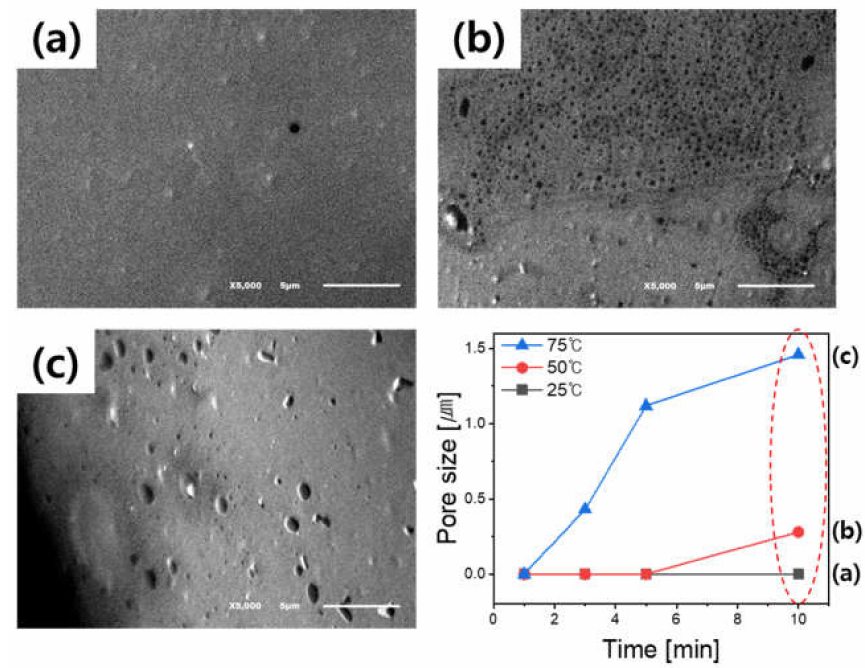
Figure 3. Pore diameter of 3D printed PEKK as a function of swelling time and temperature: ( a ) 25 ◦ C, ( b ) 50 ◦ C and ( c ) 75 ◦